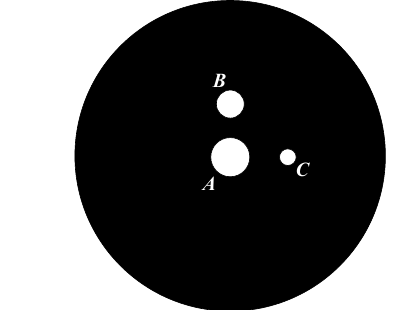
Fig. 2. Design diagram of cooperative